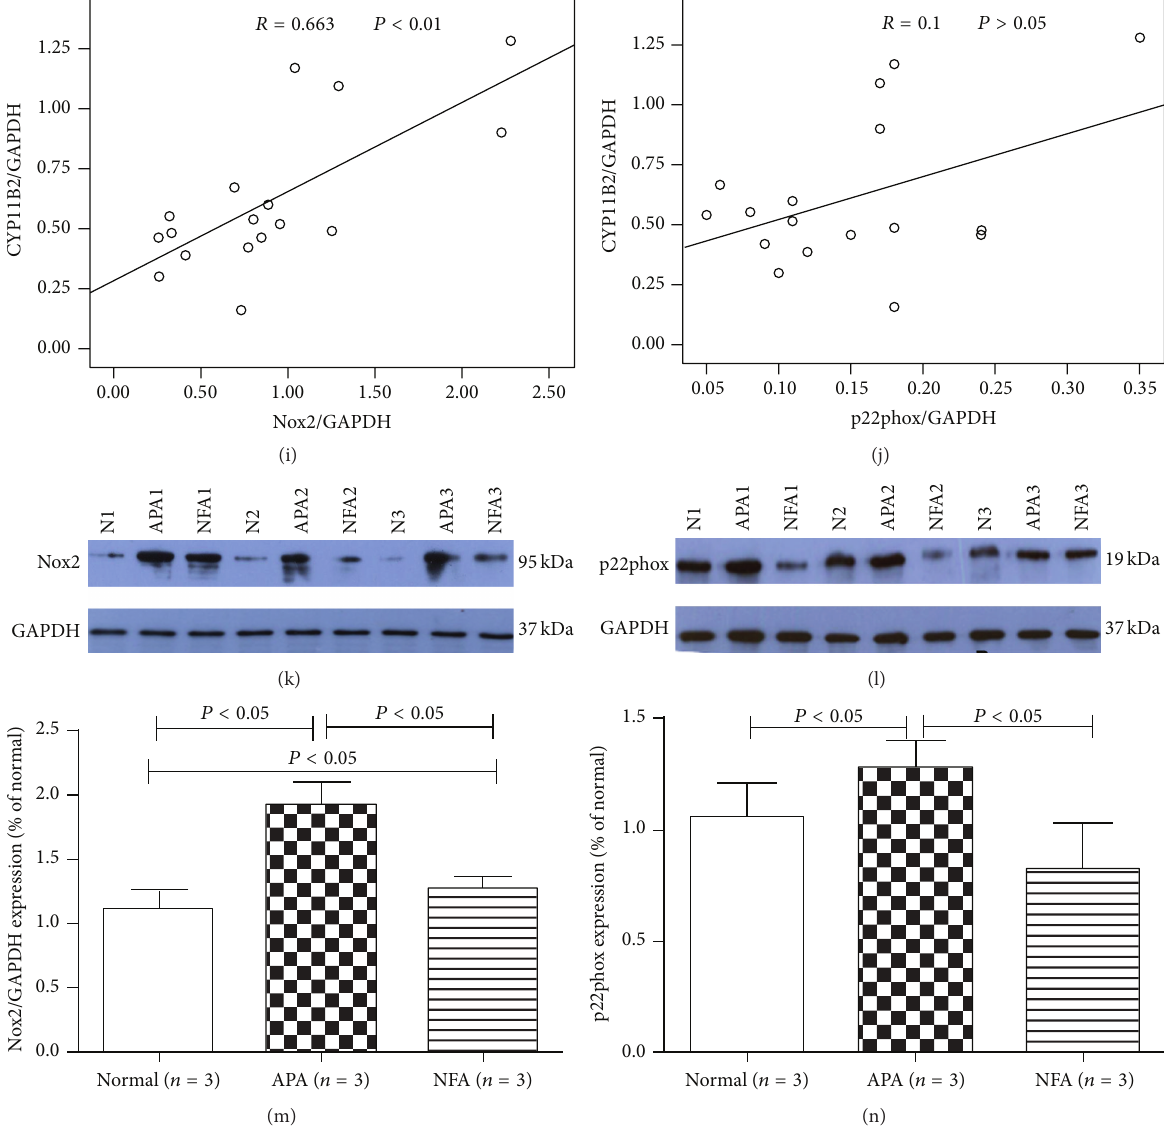
a link between oxidative stress and aldosterone